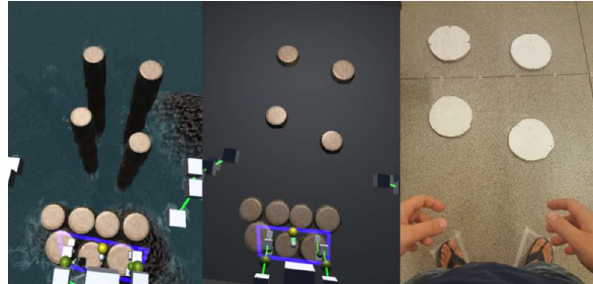
Fig. 10 Test scenarios, from left to right: testing area, office and sea virtual